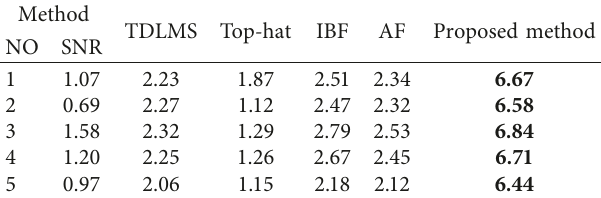
Table 4: Background inhibitor factor results for different